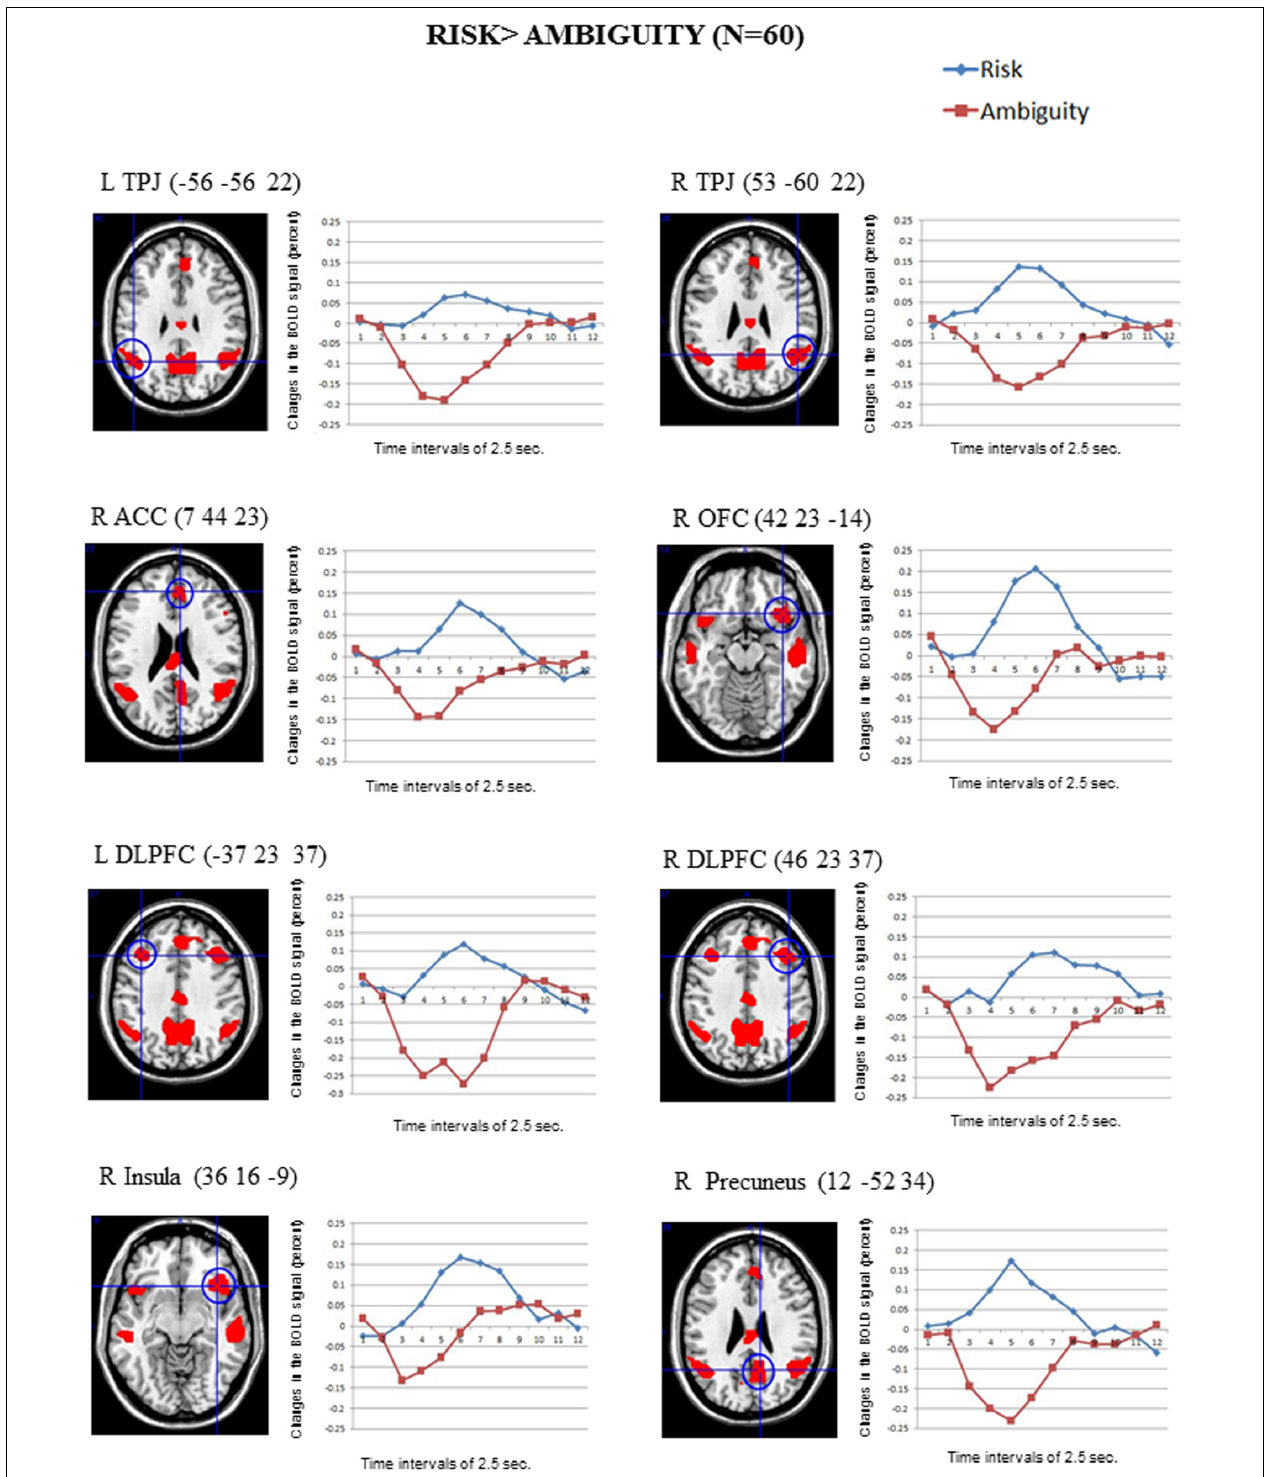
FIGURE 2 |The clusters of activation in the whole-brain analyses for the contrast Risk > Ambiguity (corrected FWE, p = 001 and K > 10; N = 60) are circled for several regions. Changes in the BOLD signal (percent) across time for the same regions for the risk (blue) and the ambiguity (red) conditions are also shown, using time intervals of 2.5